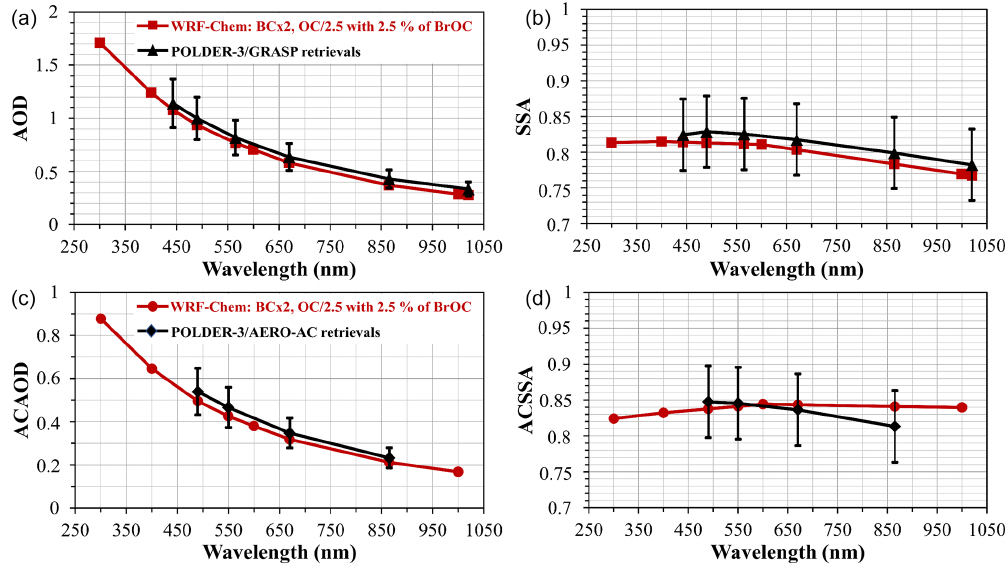
Figure 14. Spectral dependencies of AOD (a) and SSA (b) retrieved by POLDER-3/GRASP in clear sky ( a, b , black curves) and by POLDER-3/AERO-AC above clouds ( c, d , black curves) and simulated with the WRF-Chem optimized configuration (BC × 2, OC / 2 . 5 with 2.5% of BrOC, red curves). Black vertical error bars correspond to the uncertainties associated with POLDER-3 data with an accuracy of ± 15% (per pixel estimate) on the aerosol optical depth and ± 0 . 05% (per pixel estimate) on the single scattering albedo over the entire spectral domain. Values are averaged geographically on their respective study areas – (12–30 ◦ E, 10–0 ◦ S) over the southern African continent in clear sky and (0–15 ◦ E, 15–5 ◦ S) above clouds over the southeastern Atlantic Ocean – and temporally over the first half of July